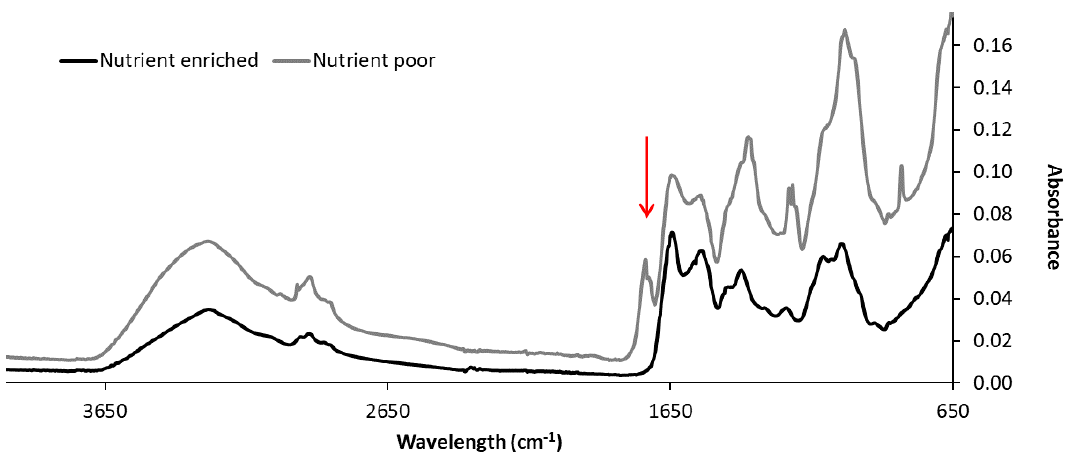
Figure 4. FTIR of the extracted EPS of the biofilms. The arrow shows the peak at 1730 cm − 2 associated with the ν (C=O)OH of sialic acids.